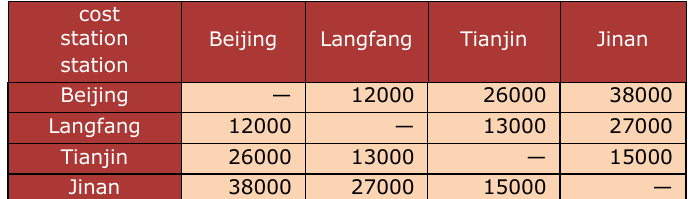
Table 8. Variable operating cost for running